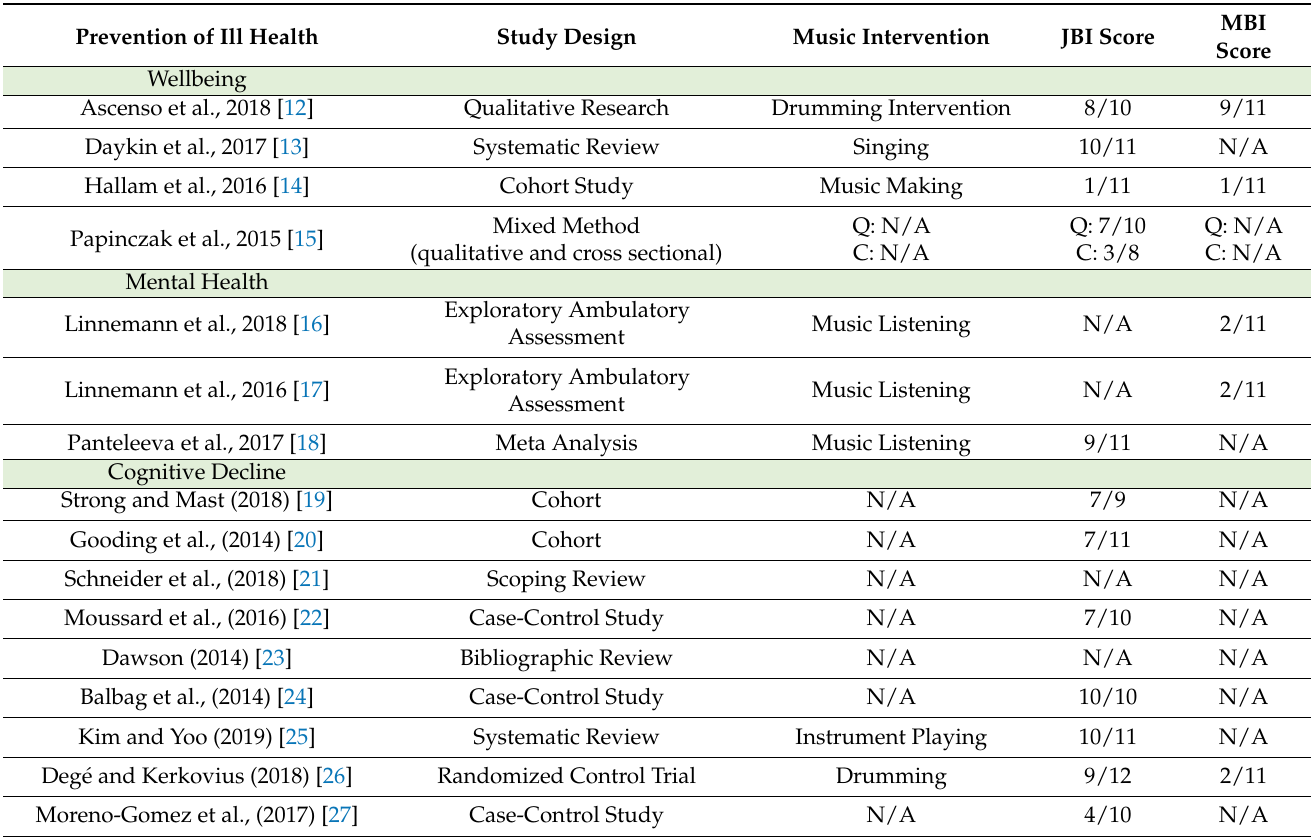
Table 3. Summary of results from Phase 2 A&B Topic: Prevention of Ill